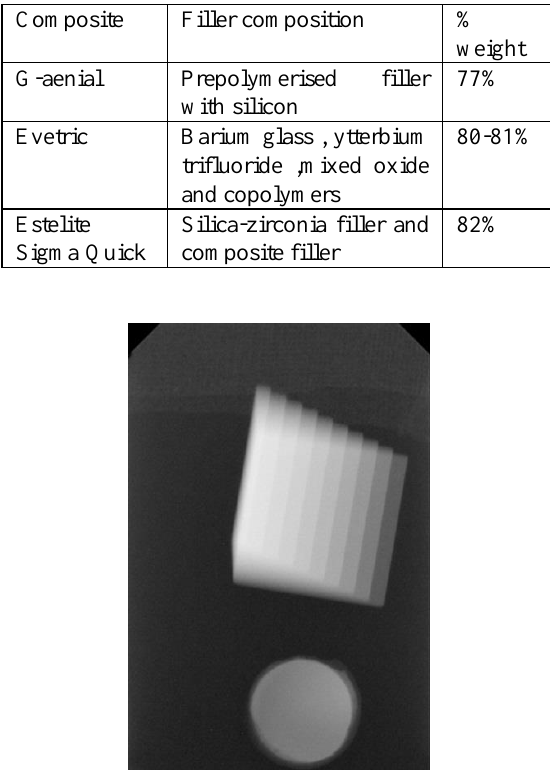
Figure 1: radiograph showing the radiopacity values of Evetric composite in relation to the